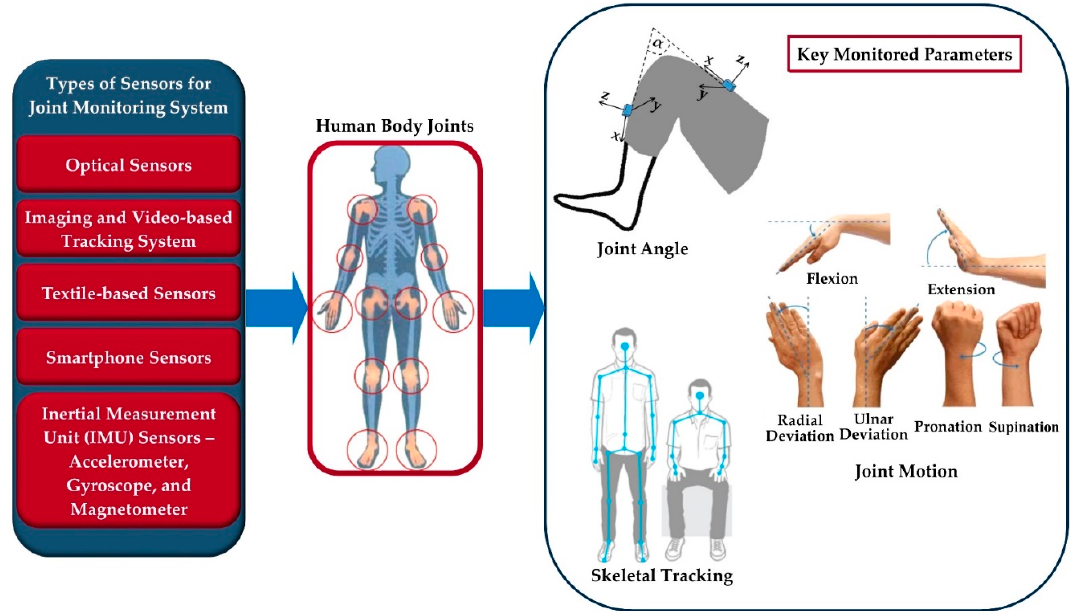
Figure 3. Joint monitoring sensor technologies and monitored parameters.